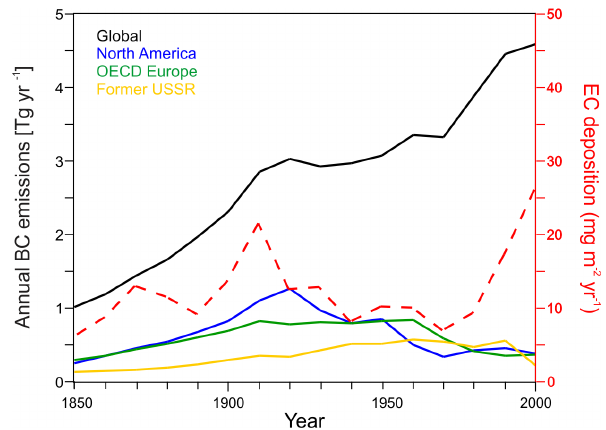
Figure 4. Global, North American, OECD European and former USSR annual anthropogenic fossil fuel BC emissions (emissions from Bond et al., 2007) compared to measured EC deposition in the Holtedahlfonna ice core (dashed line) between 1850 and 2000. The EC deposition is shown in 10-year